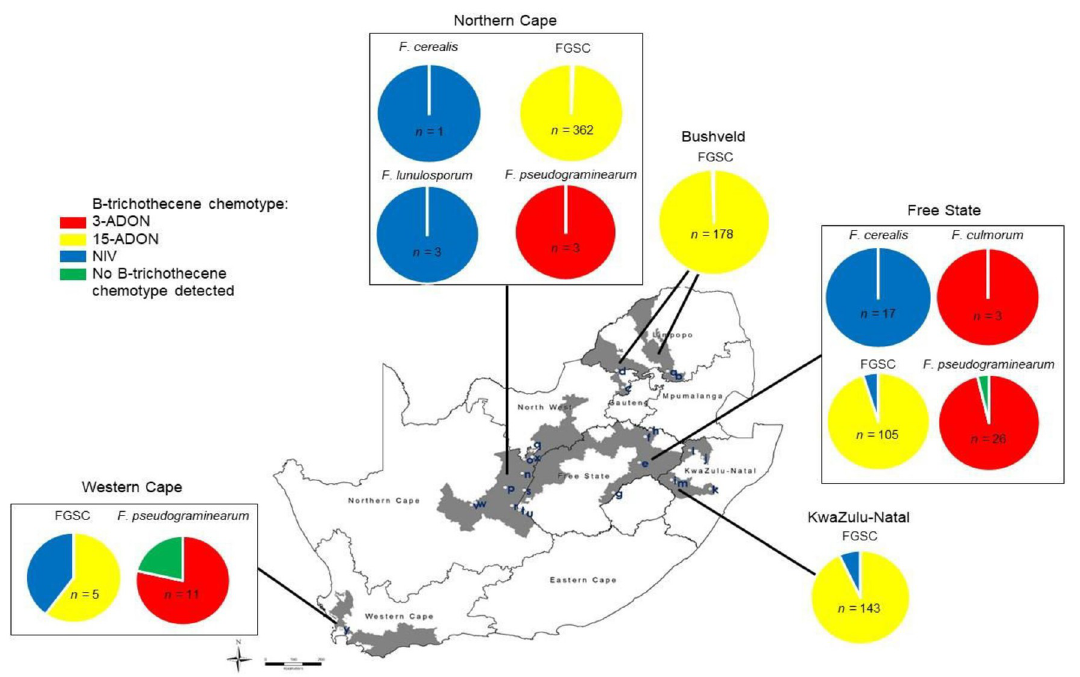
Fig 2. Incidence of type B trichothecene chemotypes of different members of the Fusarium sambucinum species complex (FSAMSC) obtained from diseased wheat heads in South Africa during 2008 and 2009, according to the total number of FSAMSC isolates obtained ( n ). Bushveld: a = Marble Hall, b = Groblersdal, c = Brits, d = Koedoeskop; Free State: e = Bethlehem, f = Frankfort, g = Ladybrand, h = Villiers; KwaZulu-Natal, i = Bergville, j = Dundee, k = Greytown, l = Newcastle, m = Winterton; Northern Cape: n = Barkly West, o = Bull Hill, p = Douglas, q = Hartswater, r = Hopetown, s = Modderrivier, t = Orania 1, u = Orania 2, v = Prieska, w = Remhoogte, x = Vaalharts; Western Cape: y = Vissershok. FGSC = Fusarium graminearum species complex, species observed include F . graminearum , F . boothii , F . meridionale , F . acaciae-mearnsii , F . brasilicum , and F . cortaderiae . B-trichothecene chemotype: 3-ADON = 3-acetyldeoxynivalenol, 15-ADON = 15-acetyldeoxynivalenol, NIV = Nivalenol, no B-trichothecene chemotype detected = F . pseudograminearum isolates that did not produced a result with PCR to indicate its chemotype.